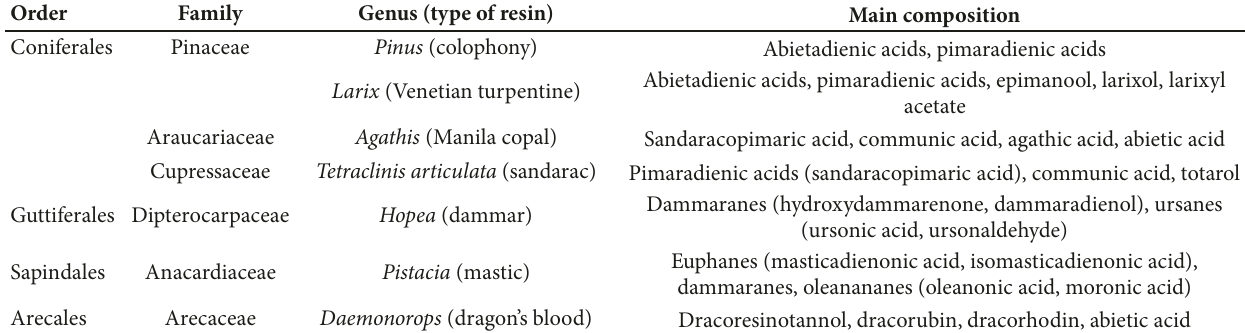
Table 4: Botanical origin and chemical composition of the analyzed plant resins